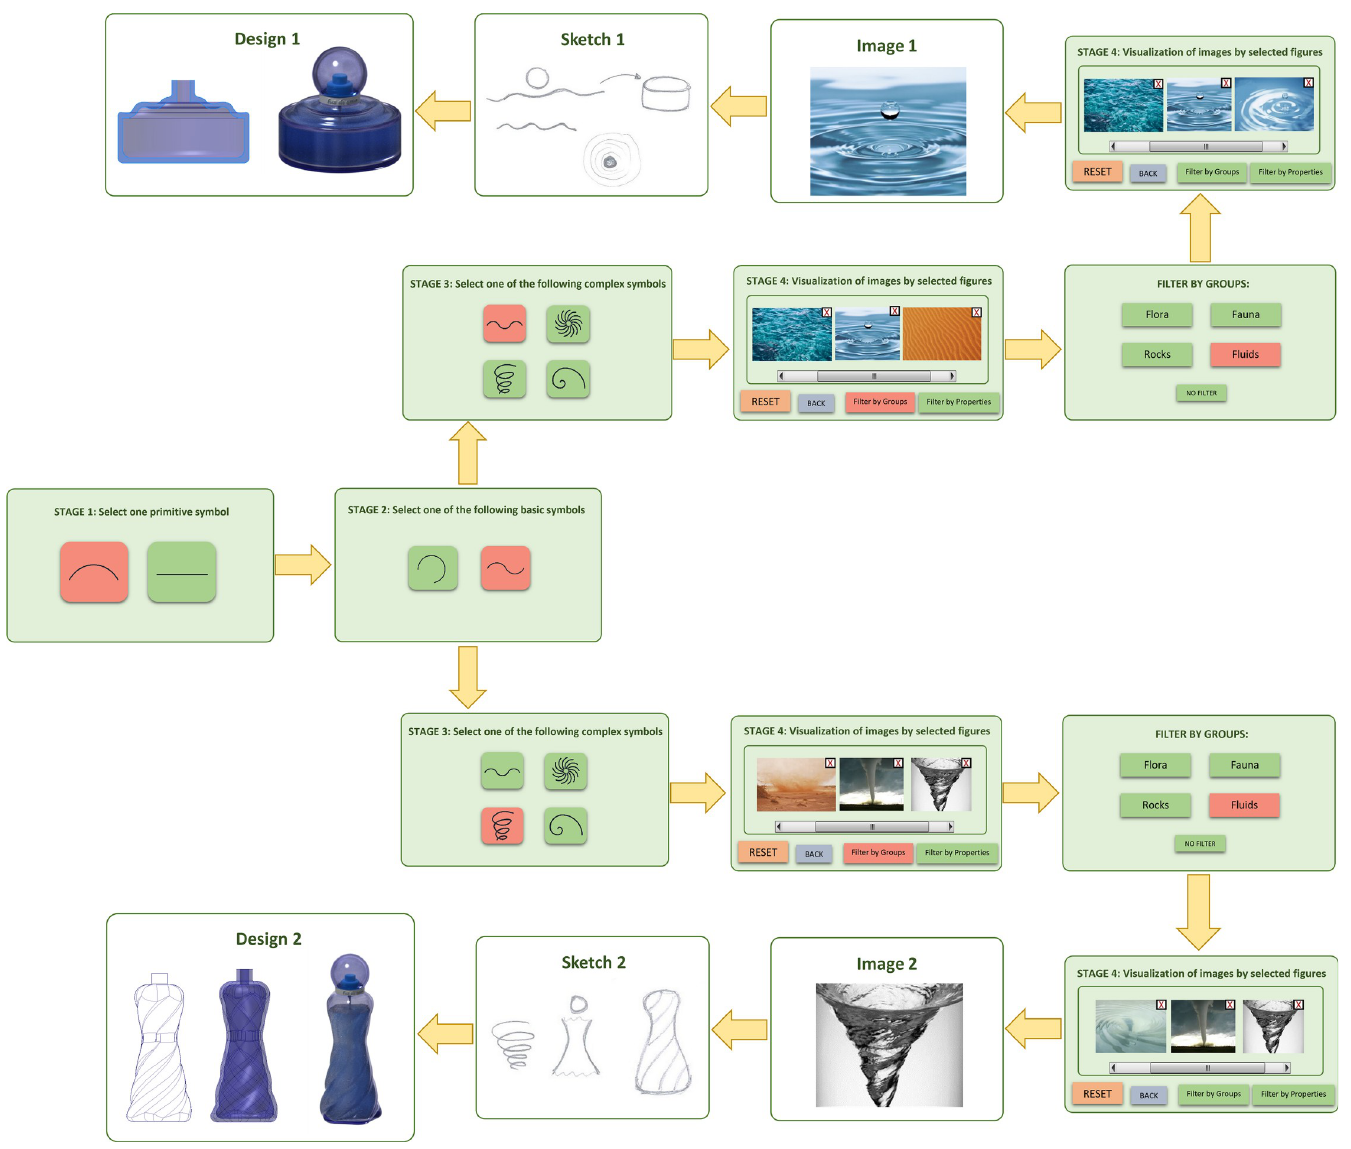
Fig 5. Search process for ideas to design a perfume